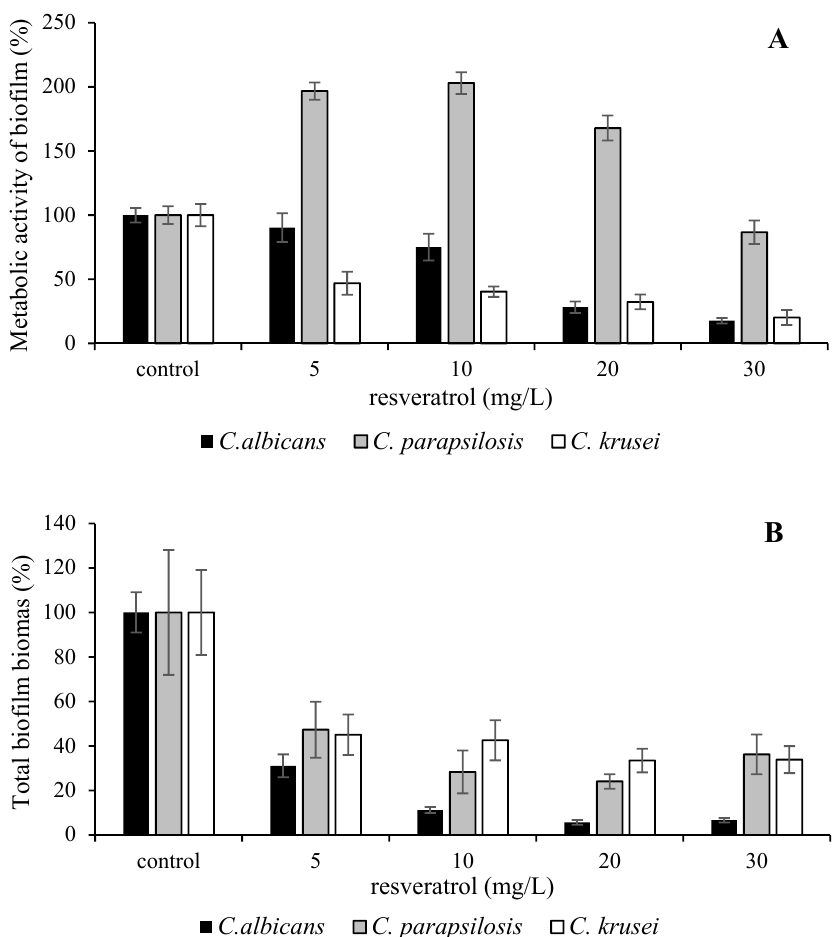
Figure 1. The influence of resveratrol in cane extract on C. albicans DBM 2164, C. parapsilosis DBM 2165 and C. krusei CCM 8271. The metabolic activity of biofilm ( A ); the total biofilm biomass ( B ); control 100% (no agent). Error bars represent standard deviation.